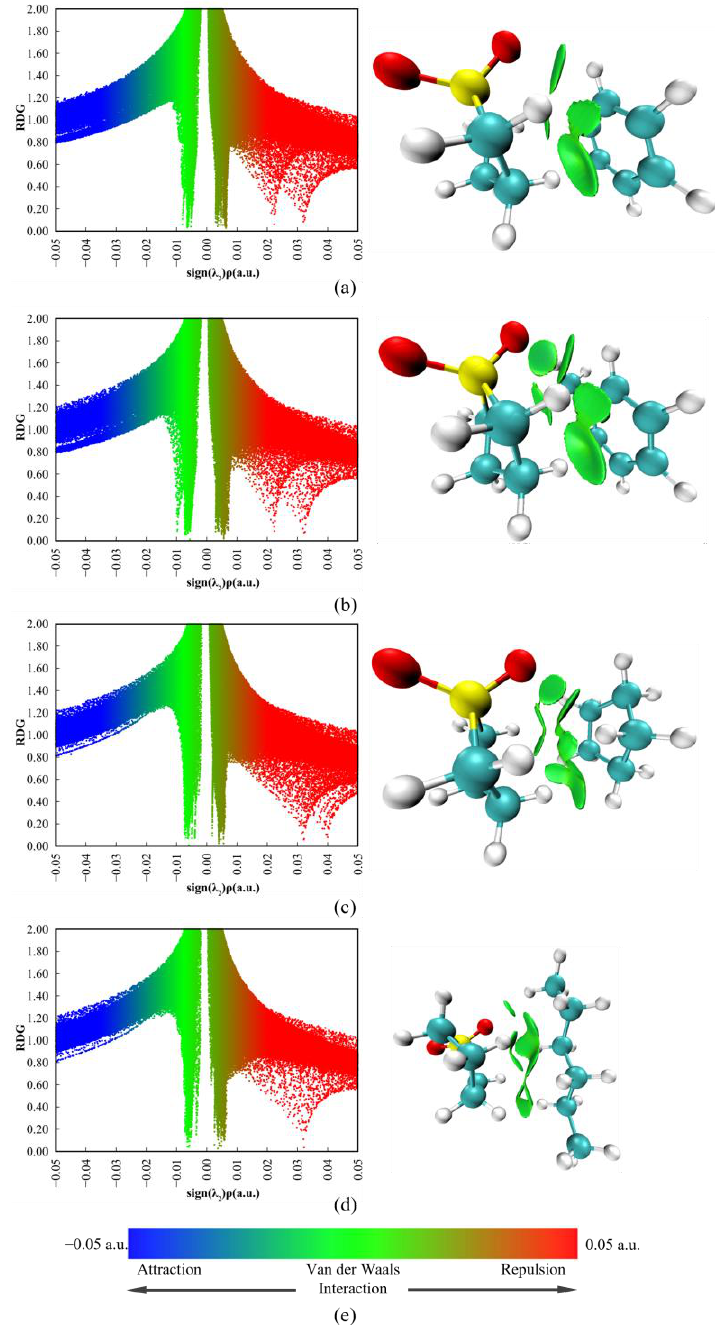
Figure 6. The RDG ( left ) and IGMH ( right ) of different complexes. ( a ) Sulfolane–Benzene; ( b ) Sulfolane–Toluene; ( c ) Sulfolane–Cyclopentane; ( d ) Sulfolane– n -Hexane; ( e ) The colors represented by the different sign( λ 2 ) ρ (a.u.) values and the types of their corresponding interactions. (IGMH isovalue = 0.006).